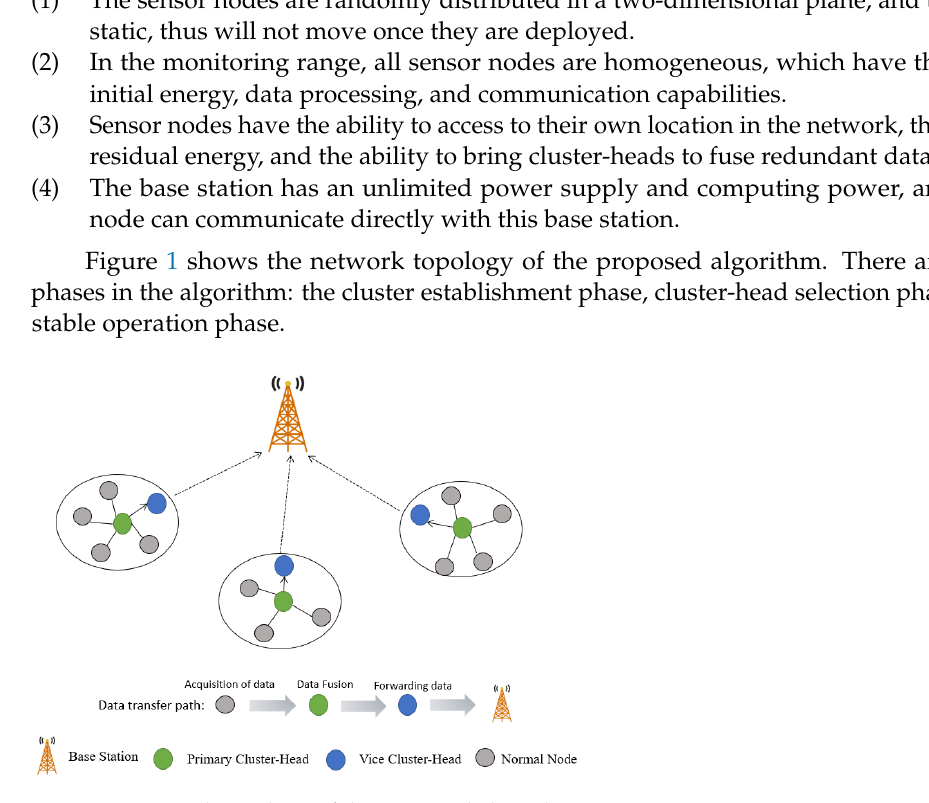
Figure 1. Network topology of the proposed algorithm.